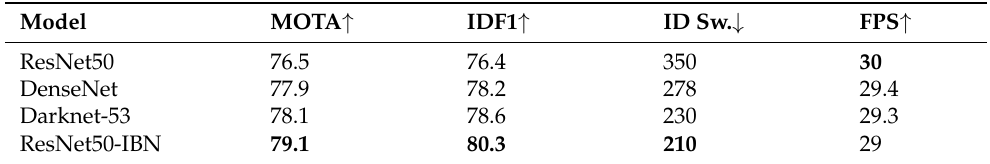
Table 1. Comparison of different backbone networks on the validation set. The best results are shown in bold.